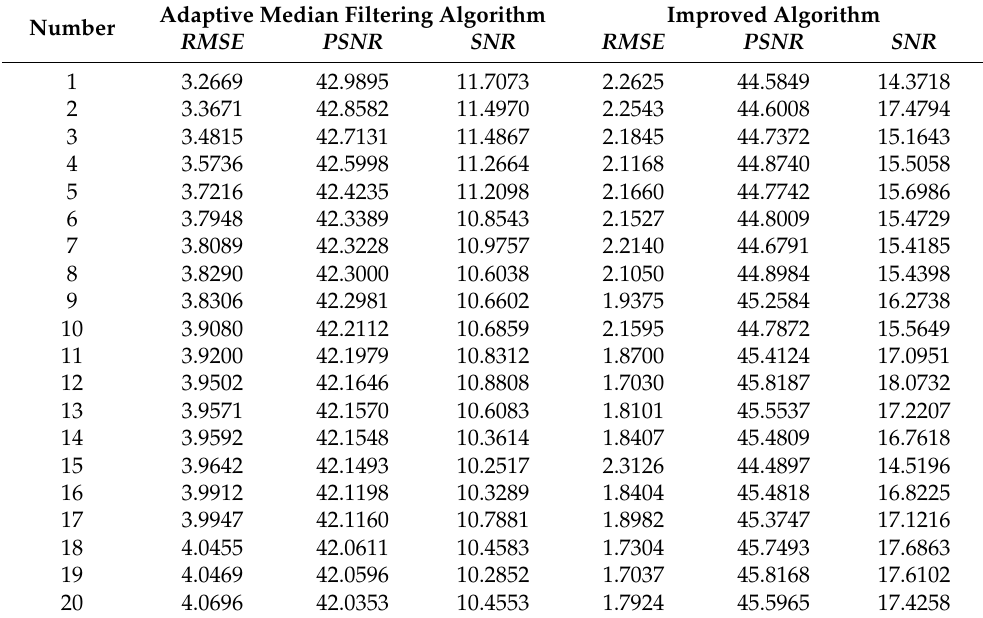
Table 1. Comparison of RMSE , PSNR and SNR between